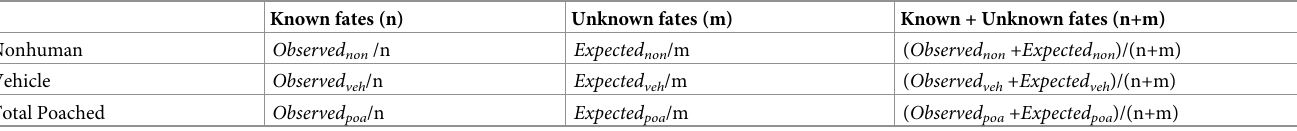
Table 3. Equations used to estimate risk from nonhuman, vehicle and poached